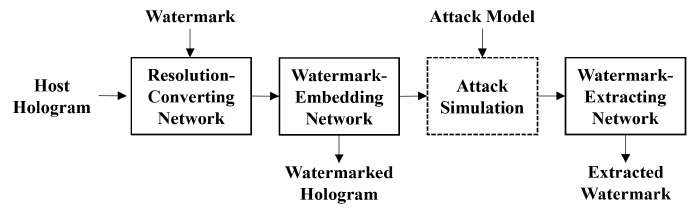
Figure 1. Structure of deep neural network for the proposed watermarking.